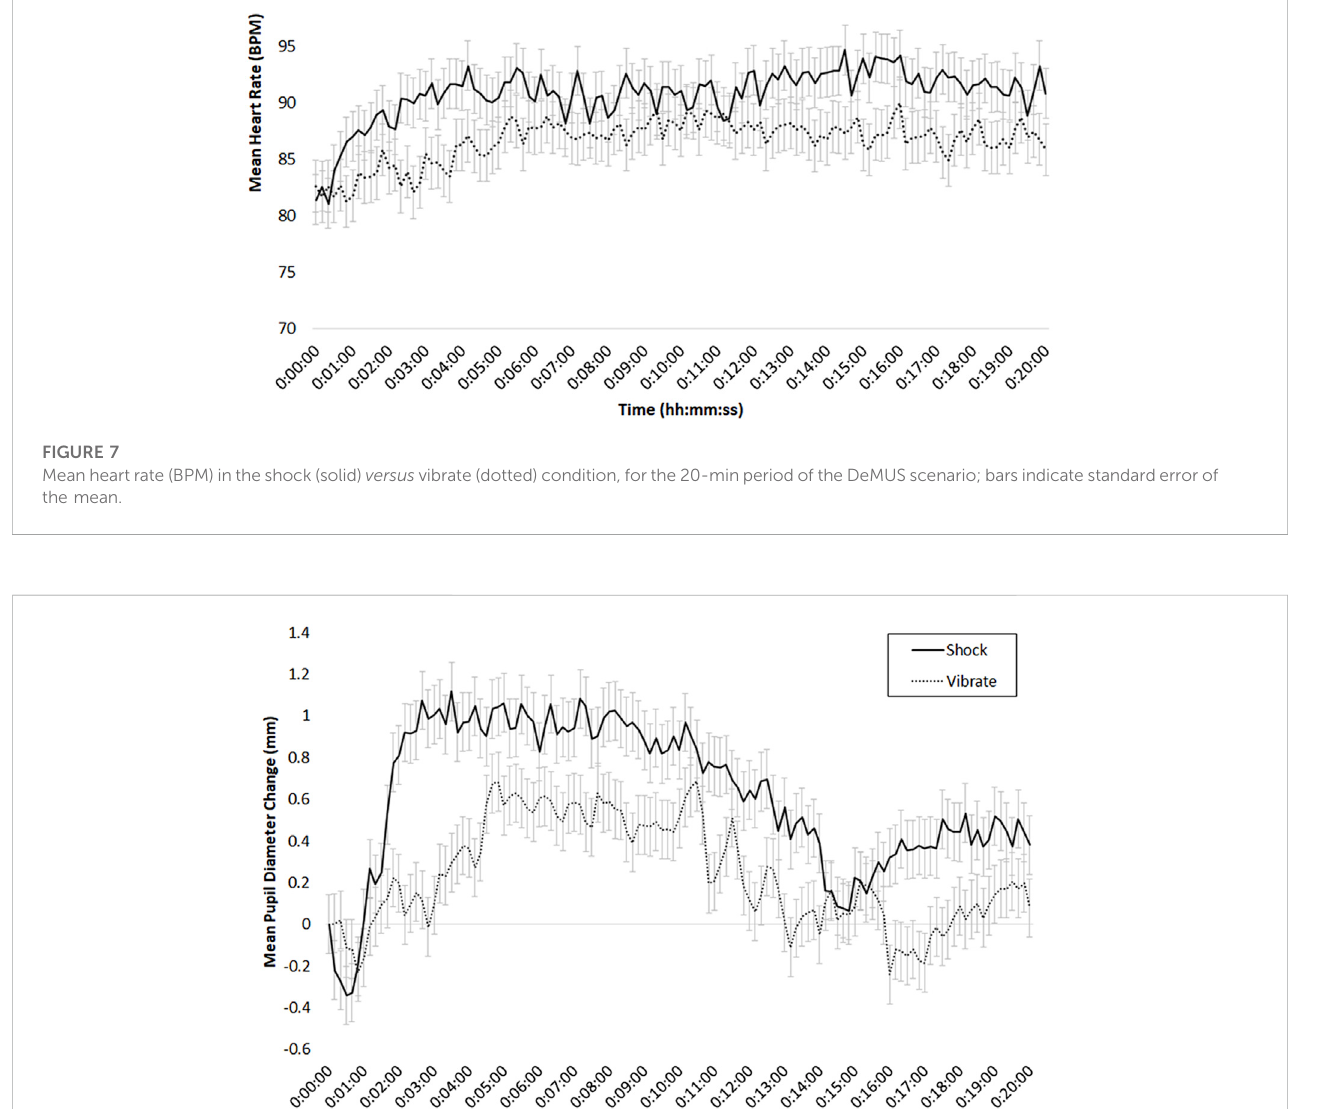
Frontiers in Virtual